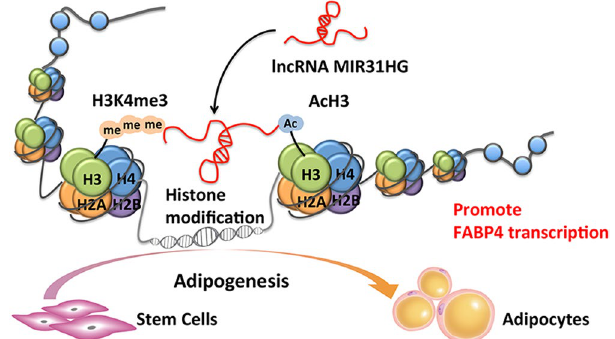
Figure 8. Schematics showing the regulation of adipogenesis by MIR31HG . MIR31HG promoted adipogenic differentiation of stem cells. In mechanism, MIR31HG contributed to histone H3 lysine 4 trimethylation and H3 acetylation at the FABP4 gene locus and promoted its transcription, leading to the promotion of